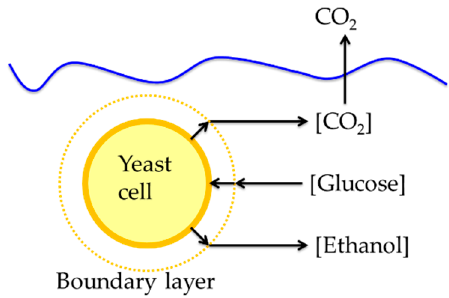
Figure 2. Diagram showing substrate and product mass transfer pathways to a yeast cell during fermentation.